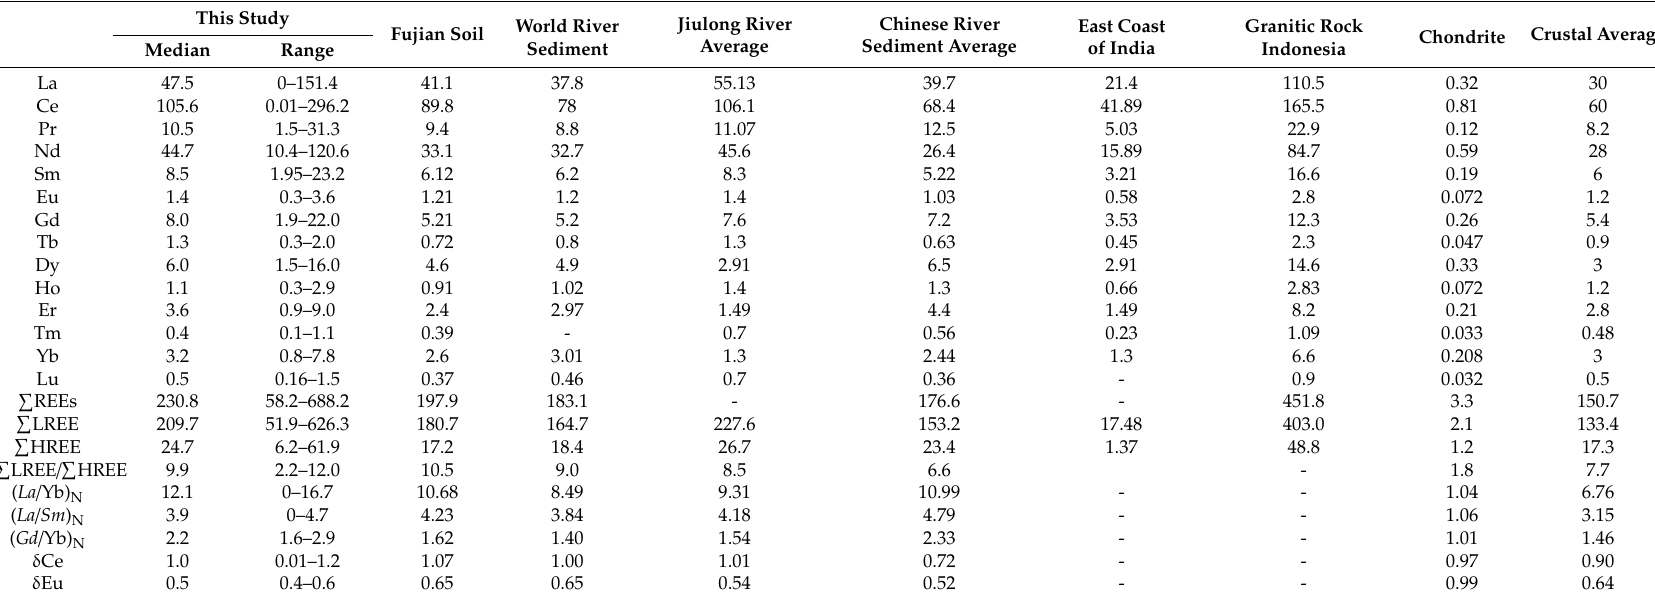
Table 1. Comparison of concentration (mg kg − 1 ) and characteristics parameters of rare earth elements (REEs) in Jiulong River Estuary from this study with the averages of Fujian soil [50]; World river sediments [51]; Jiulong River sediments [52]; Chinese river sediment average [53]; east coast of India [48]; granitic rock of Indonesia [49]; chondrite [41] and Earth’s crustal